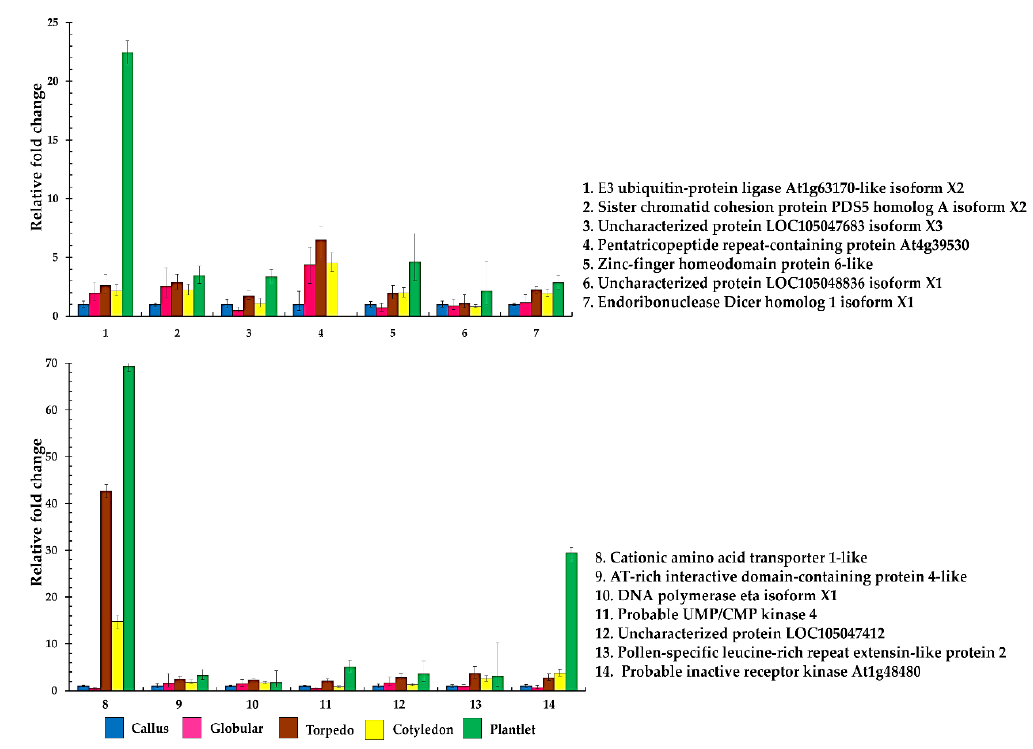
Figure 4. mRNA expression patterns derived from differentially expressed phosphoproteins .